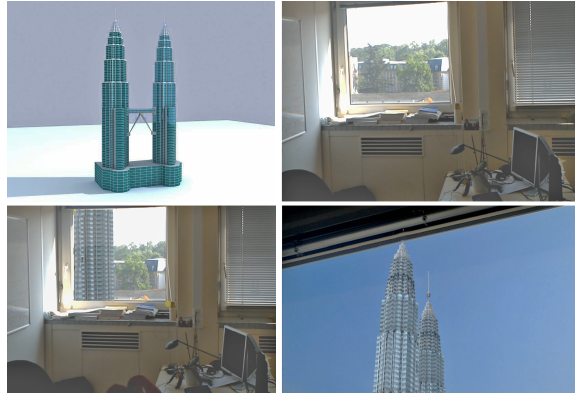
Figure 7. 3D building model (top-left); real view of the construction site through an office window (top-right);